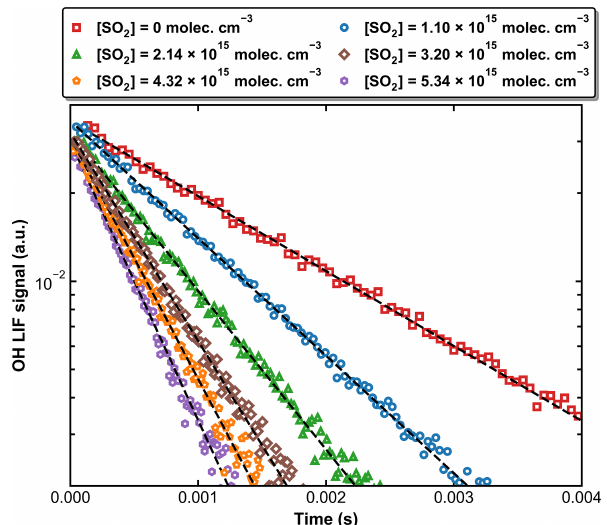
Figure 4. Exponential decay of OH at 298K and 59.9Torr (N 2 bath gas) in the presence of six different SO 2 concentrations. OH was generated by the photolysis of H 2 O 2 at 248nm. The dashed black lines are fits using Eq. (1).